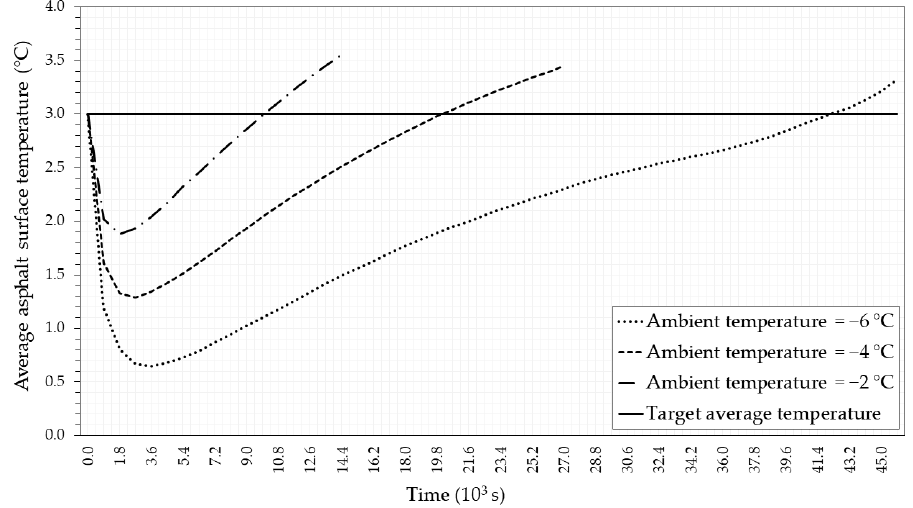
Figure 9. Time interval required to reach and maintain an average temperature of 3 °C at the asphalt surface with initialization at 3 °C. The profiles in Figure 9 suggest that to be operational the HRS requires only 41.200